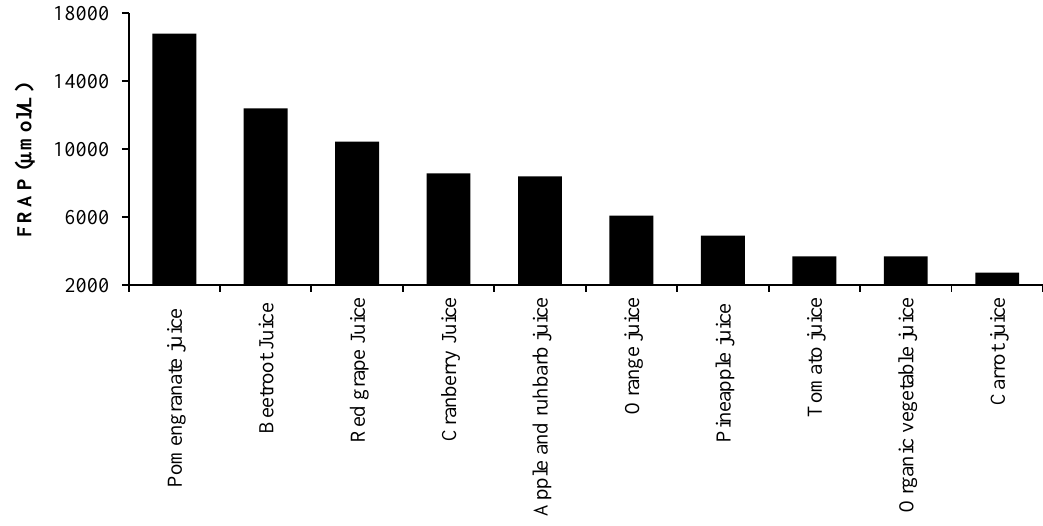
Figure 2. A comparison of the 2,2-diphenyl-1-picrylhydrazyl (DPPH•) inhibiting capacity (%) exhibited by 10 popular fruit and vegetable beverages available in the UK (values based on data from [56,57]).